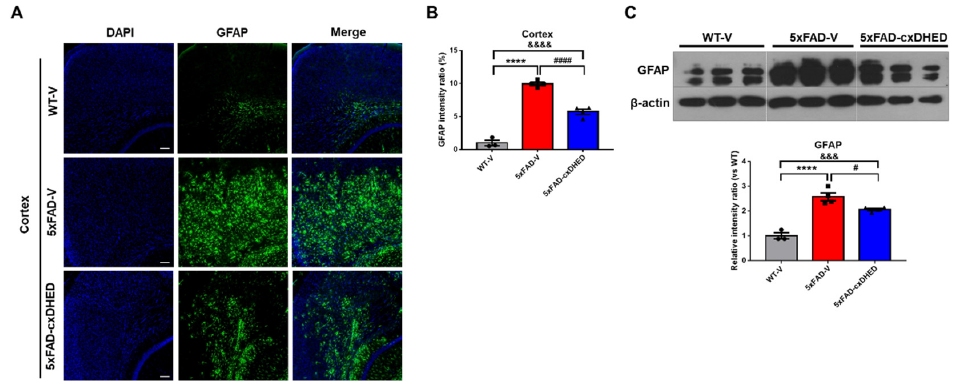
Figure 3. cx-DHED reduced astrogliosis in the brain of 5xFAD mice. ( A ) Representative image of GFAP staining in the cortex to detect astrogliosis and ( B ) the quantification of GFAP immunofluorescence in the cortex of mice. ( C ) Western blot was performed to confirm the astrocyte expression level in the cortex of model mice. Values are expressed as the mean ± standard error of the mean (WT-V; n = 3, 5xFAD; n = 4, 5xFAD-cx-DHED; n = 4). β -actin was used as a loading control. **** p < 0.0001 vs. WT-V group; &&& p < 0.001, &&&& p < 0.0001 vs. 5xFAD-cxDHED group; # p < 0.05 and